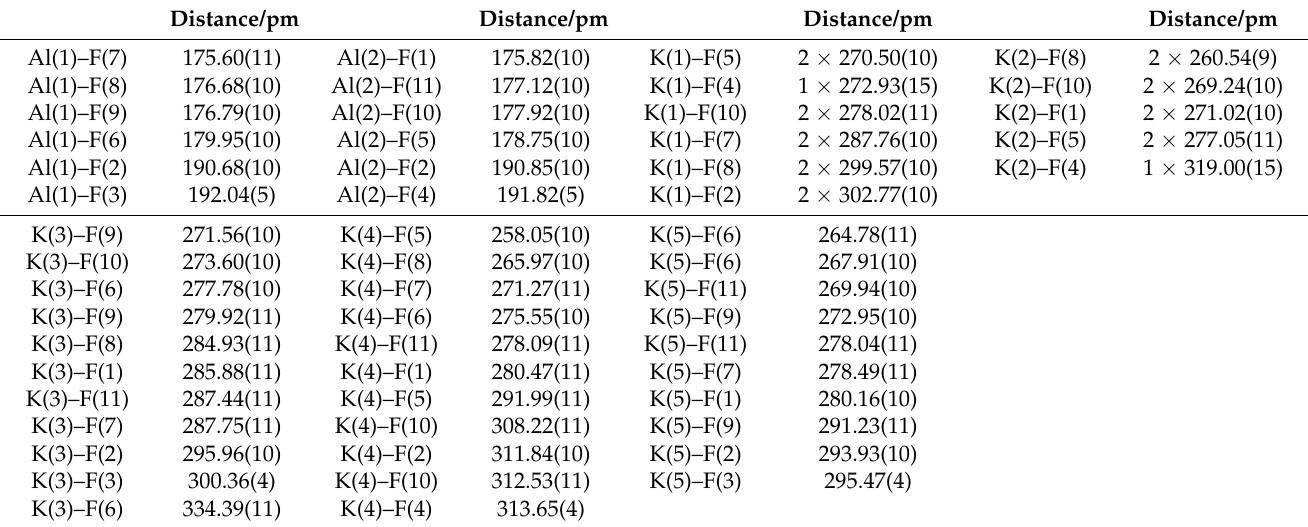
Table 5. Selected interatomic distances (in pm) in K 2 AlF 5 -3.